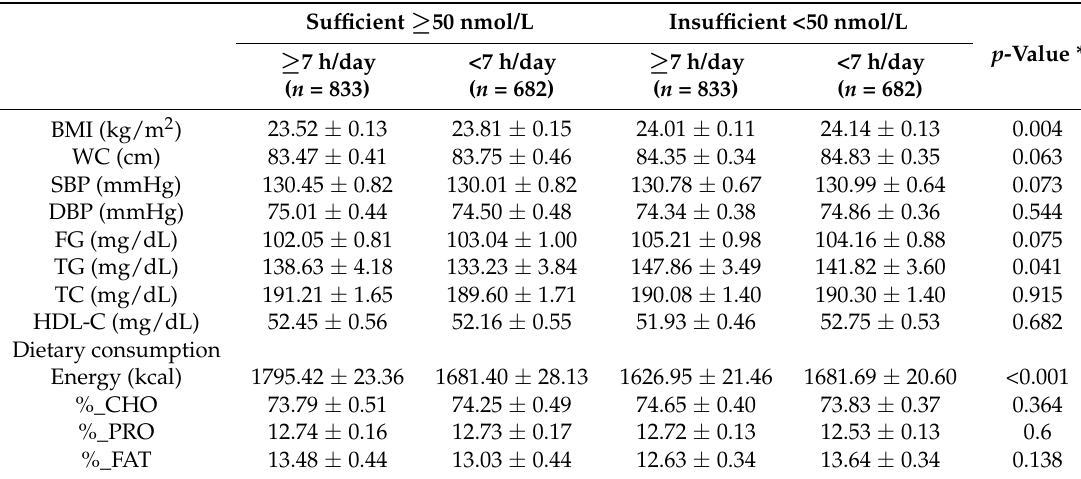
Table 3. Obesity-related variables and dietary macronutrient consumption according to the 25-hydroxyvitamin D concentration and sleep duration.